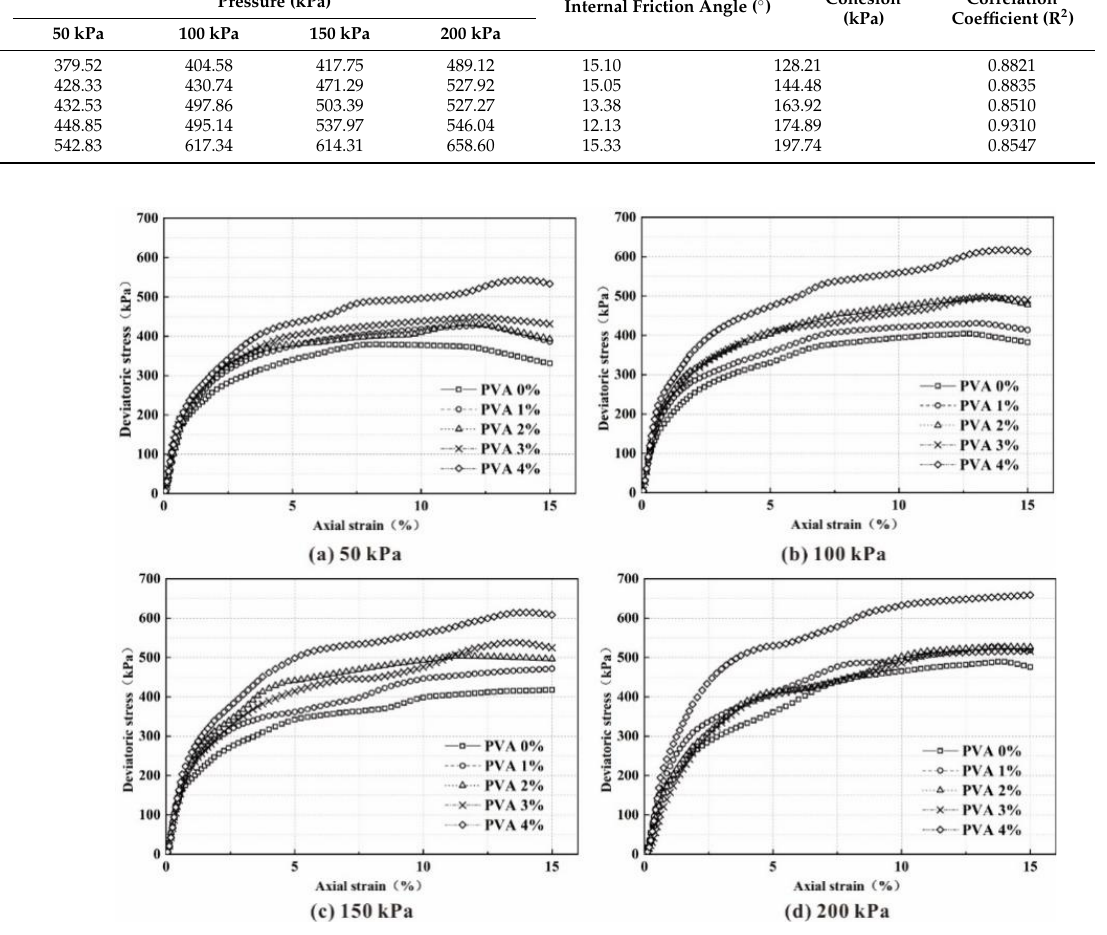
Figure 2. Deviator stress-strain curves with different amounts of polyvinyl acetate (PVA) under a confining stress of: ( a ) 50kPa; ( b ) 100 kPa; ( c ) 150 kPa; ( d ) 200 kPa.